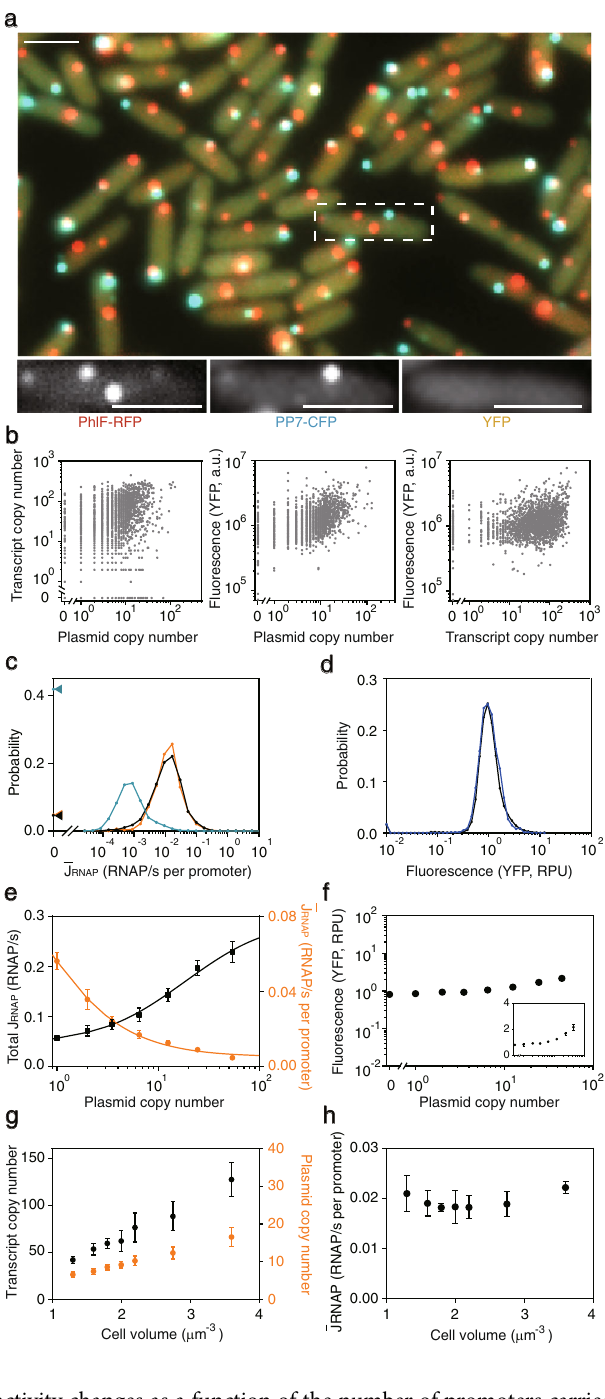
enzyme balancing as large cell-to-cell fl uctuations are buffered that would otherwise cause errors. In addition, it speaks to the futility of using high copy number plasmids to increase heterologous protein expression, where there is a diminishing return as well as a disproportionate drain on cellular resources to carry the additional plasmid copies. We also found the per promoter RNAP fl ux is largely constant for cells of different volumes (Fig. 2h), even when the transcript copy number is